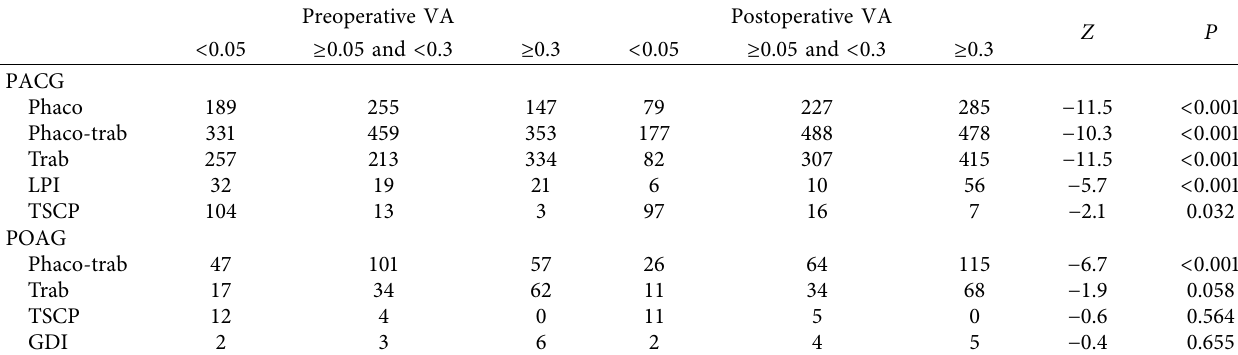
Table 5: Changes in VA after different surgical methods for primary